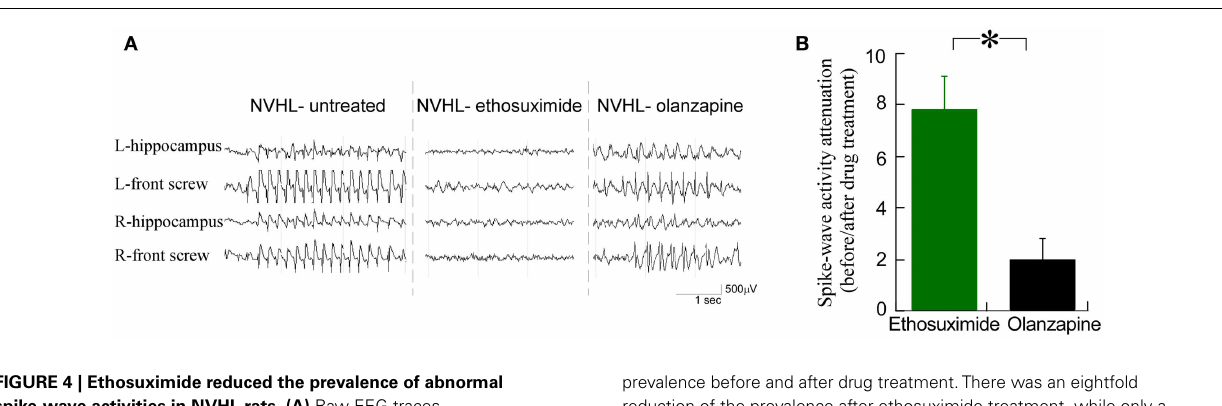
prevalence before and after drug treatment.There was an eightfold reduction of the prevalence after ethosuximide treatment, while only a twofold attenuation of the prevalence after olanzapine treatment in NVHL rats ( t 4 = 3.79, p =